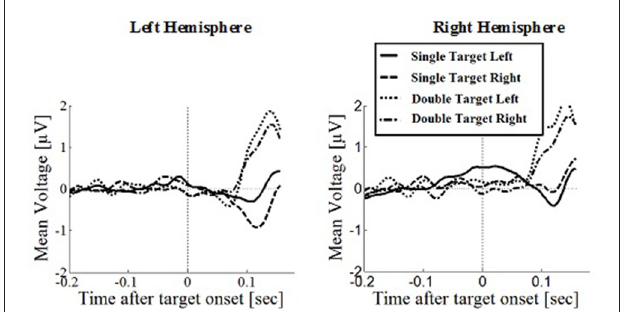
FIGURE 6 | Wave plot of the occipital response for manual response conditions in the left hemisphere (left) and the right hemisphere (right) of the brain.